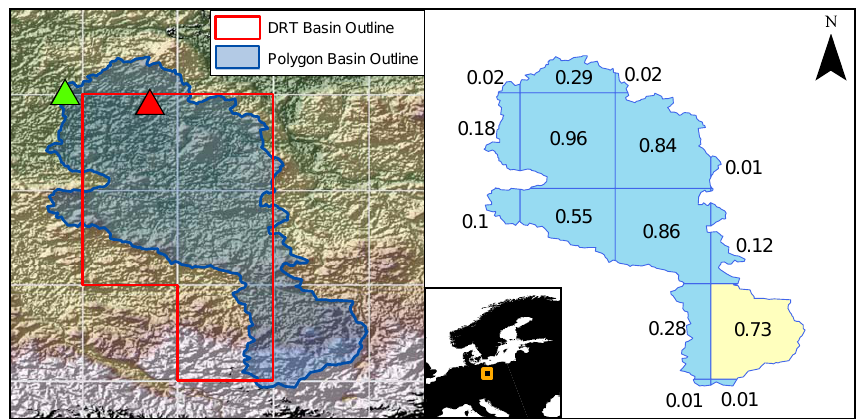
Fig. 1. Example of treatment of gridded climate data for the polygon basin delineations. Basin outline based on DRT and GIS-polygon data for Berlin M¨uhlendamm UP discharge station on the Spree River (9707km 2 ) overlaid on 0.5 ◦ climate data grid (left panel). Basin intersections with the climate grid cells labelled with the fraction of the intersecting grid area (right). For each climate grid cell, only the intersecting fraction contributes to the basin average: e.g. for the yellow polygon 73% of the precipitation falling in the climate grid cell is assumed to fall within the basin. The red triangle indicates the location of the gauge according to the GRDC archive and the green triangle the location after corrections made in the generation of the GIS-polygon